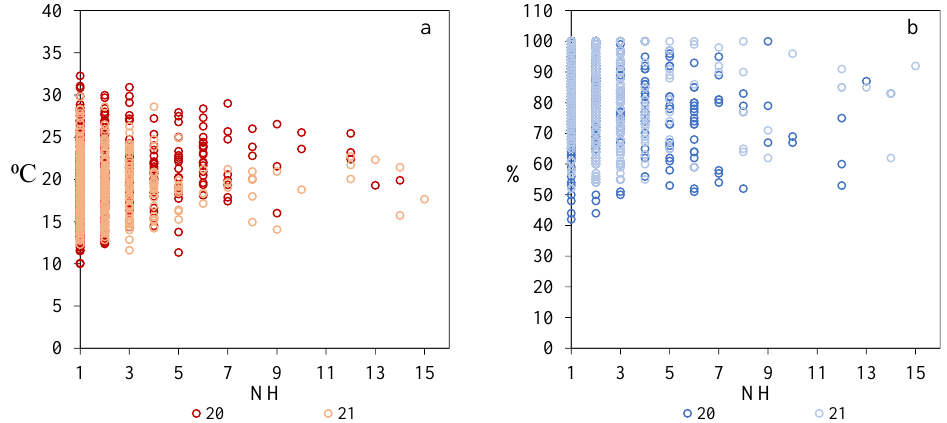
Figure 2. Relationship between the number of hornets (NH) that were found in front of the hives and the external parameters in both years, 2020 and 2021. ( a ): temperature ( ◦ C), ( b ): relative humidity (%).